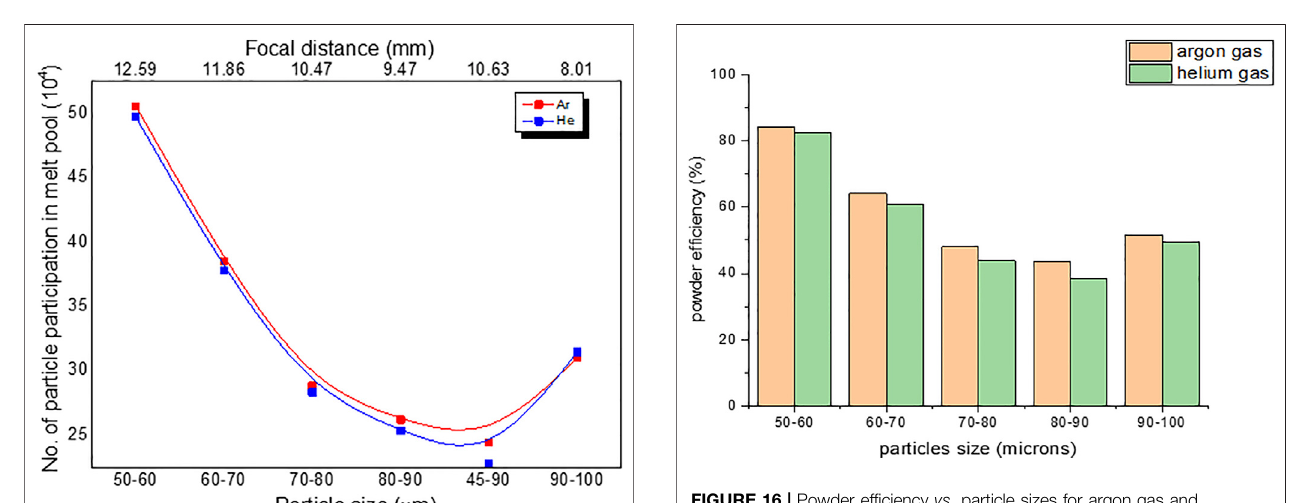
FIGURE 16 | Powder ef fi ciency vs . particle sizes for argon gas and helium